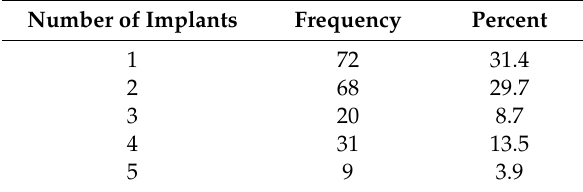
Table 3. Number of implants per